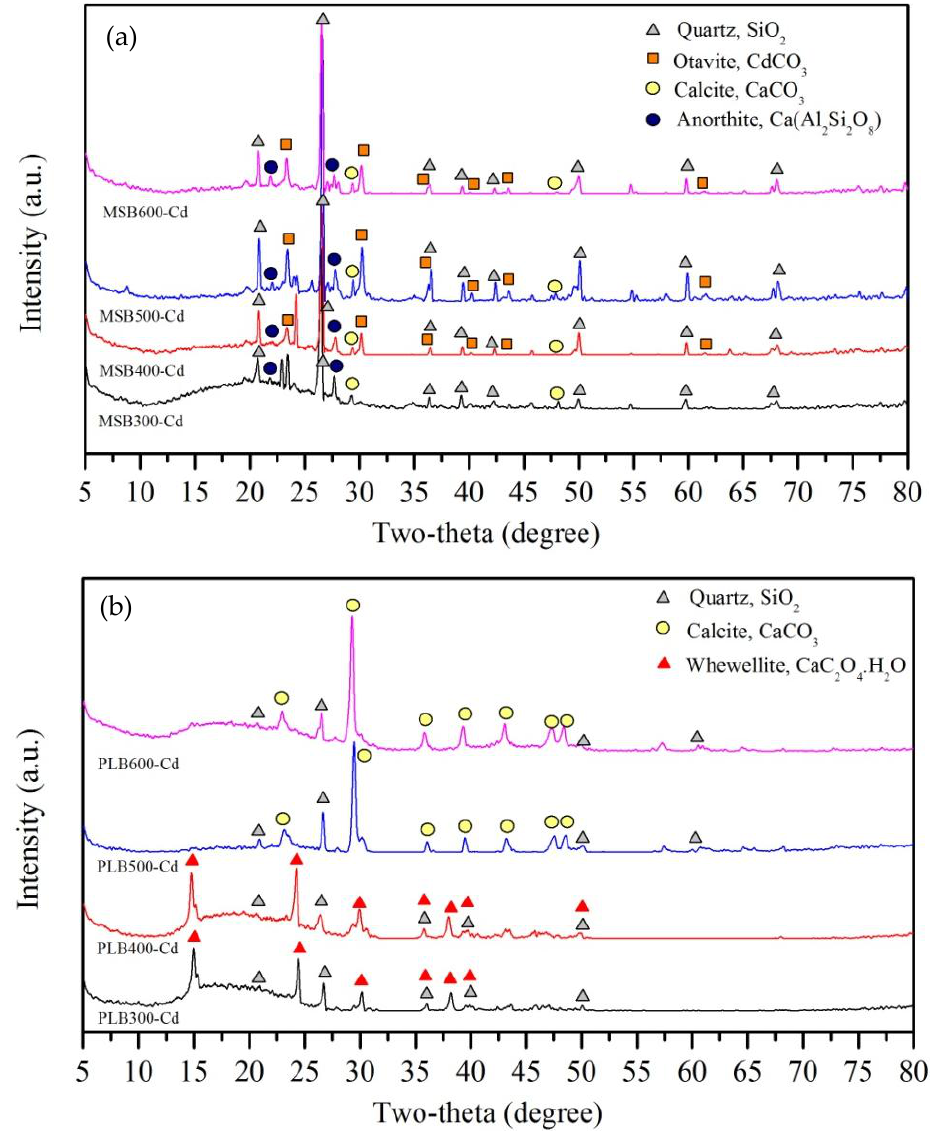
Figure 12. XRD patterns of MSB (a) and PLB (b) after reaction with Cd Figure 13. XRD patterns of MSB ( a ) and PLB ( b ) after reaction with